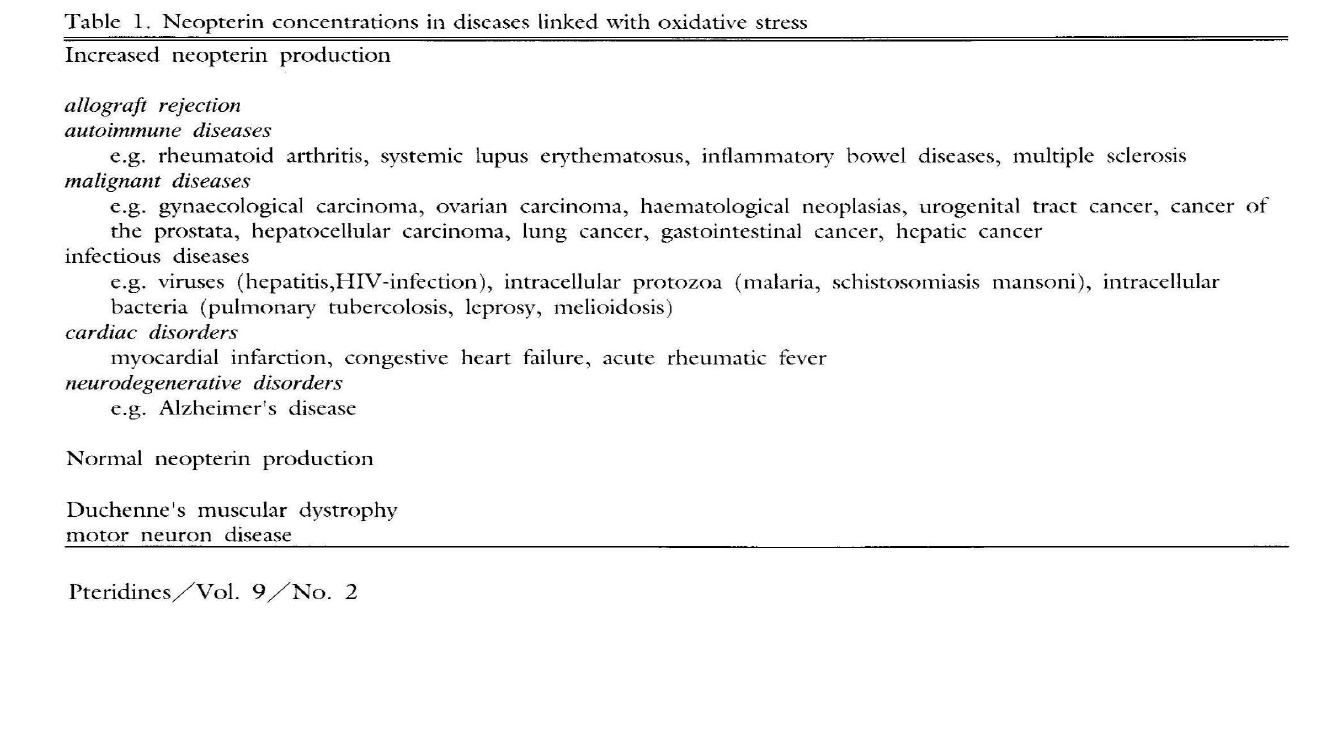
Table 1. Neopterin concentrations in diseases linked with oxidative stress Increased neopterin production allograft rejection autoimmune